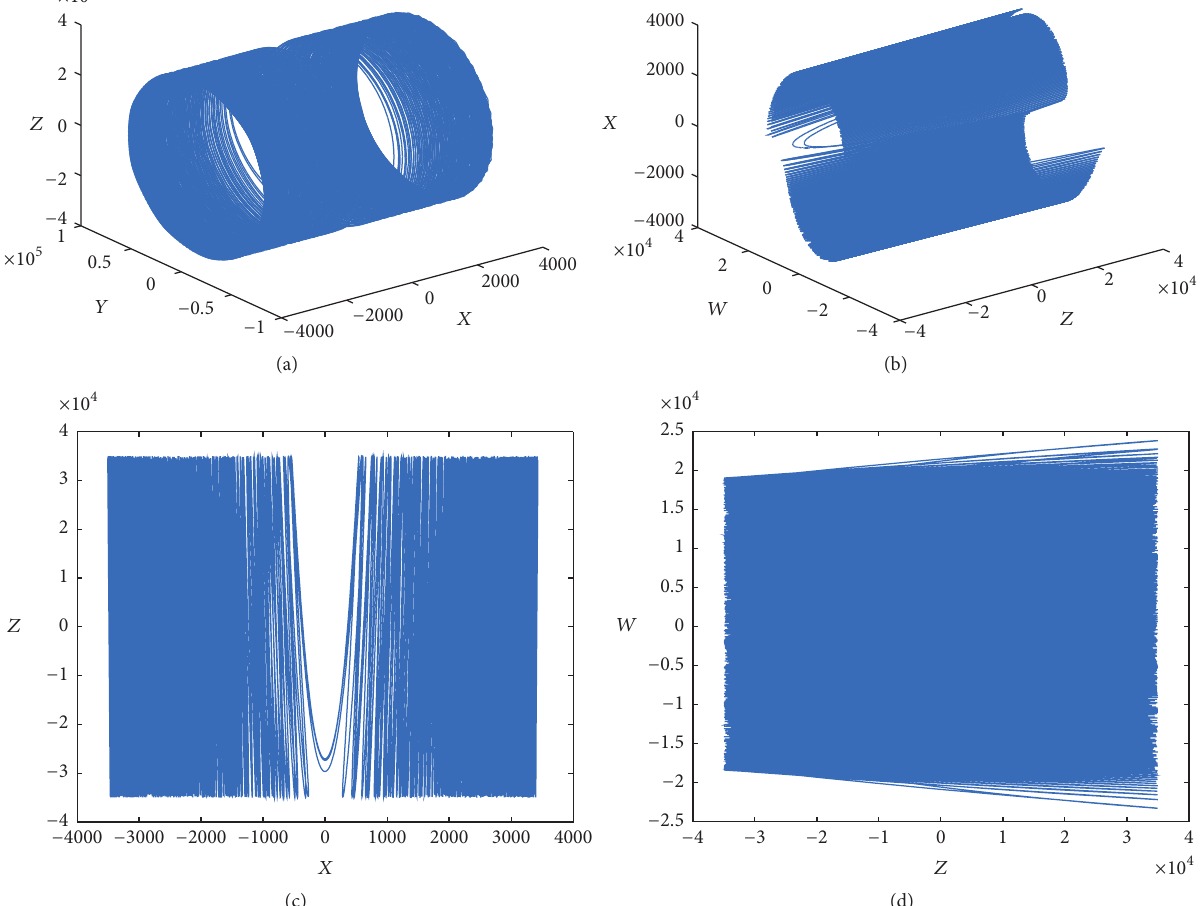
Figure 17: Different projections of the hyperchaotic attractor. Initial conditions: (−3203,−26967, 32052,−5434) .